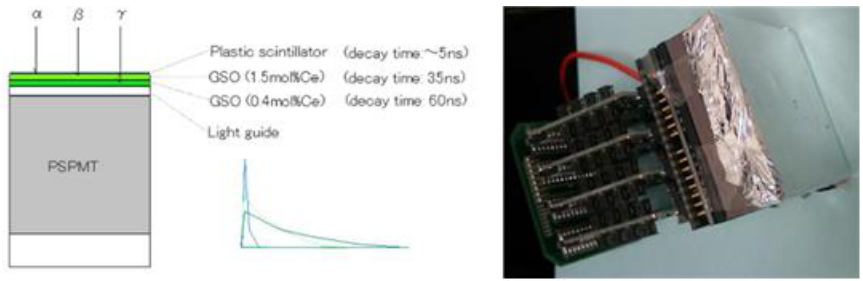
Figure 25. Alpha/beta/gamma imaging detector developed by Nagoya University [58].